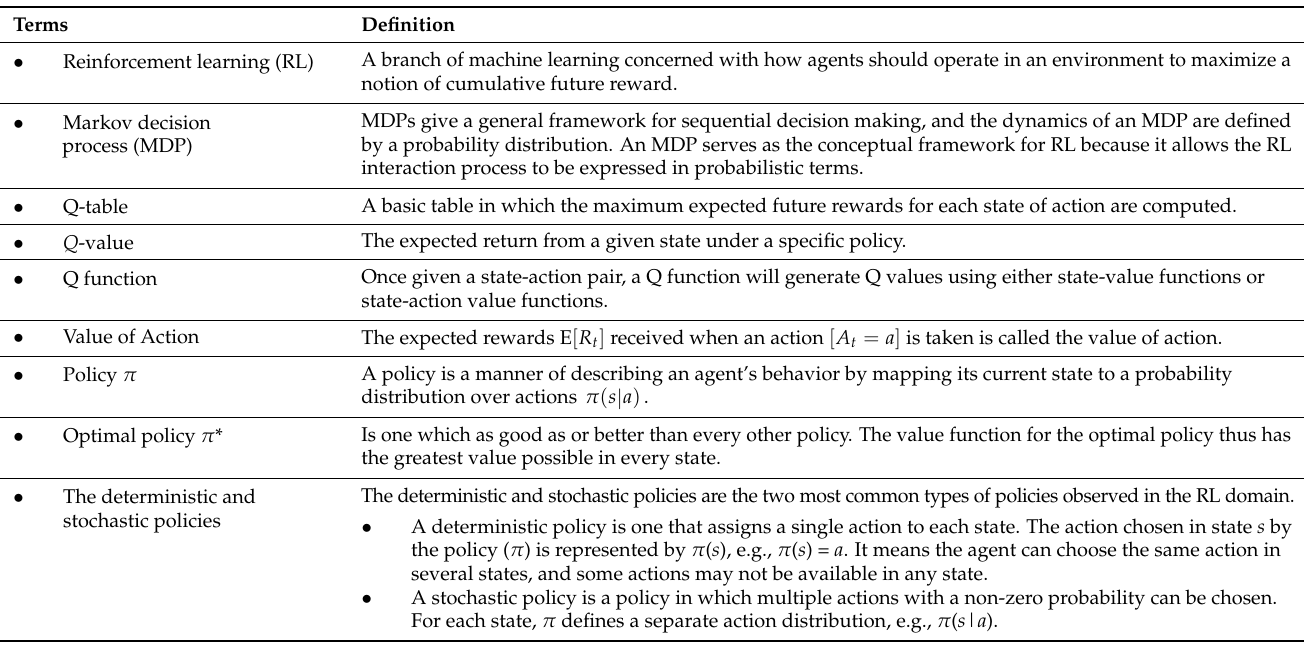
Table 1. Essential reinforcement learning